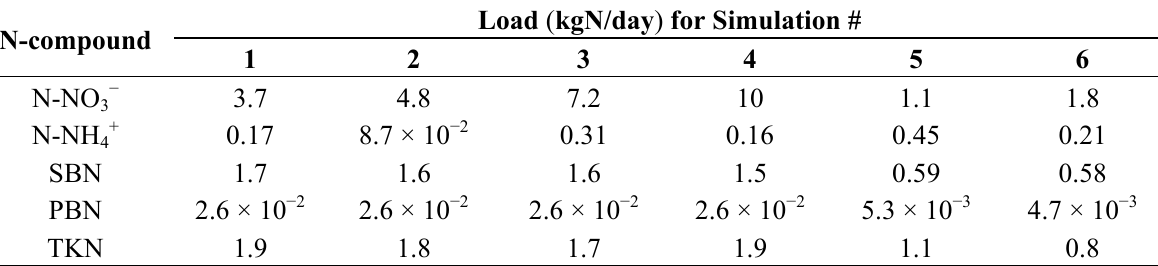
Table 4. Loads of the different N-compounds in the effluent for all simulations performed.